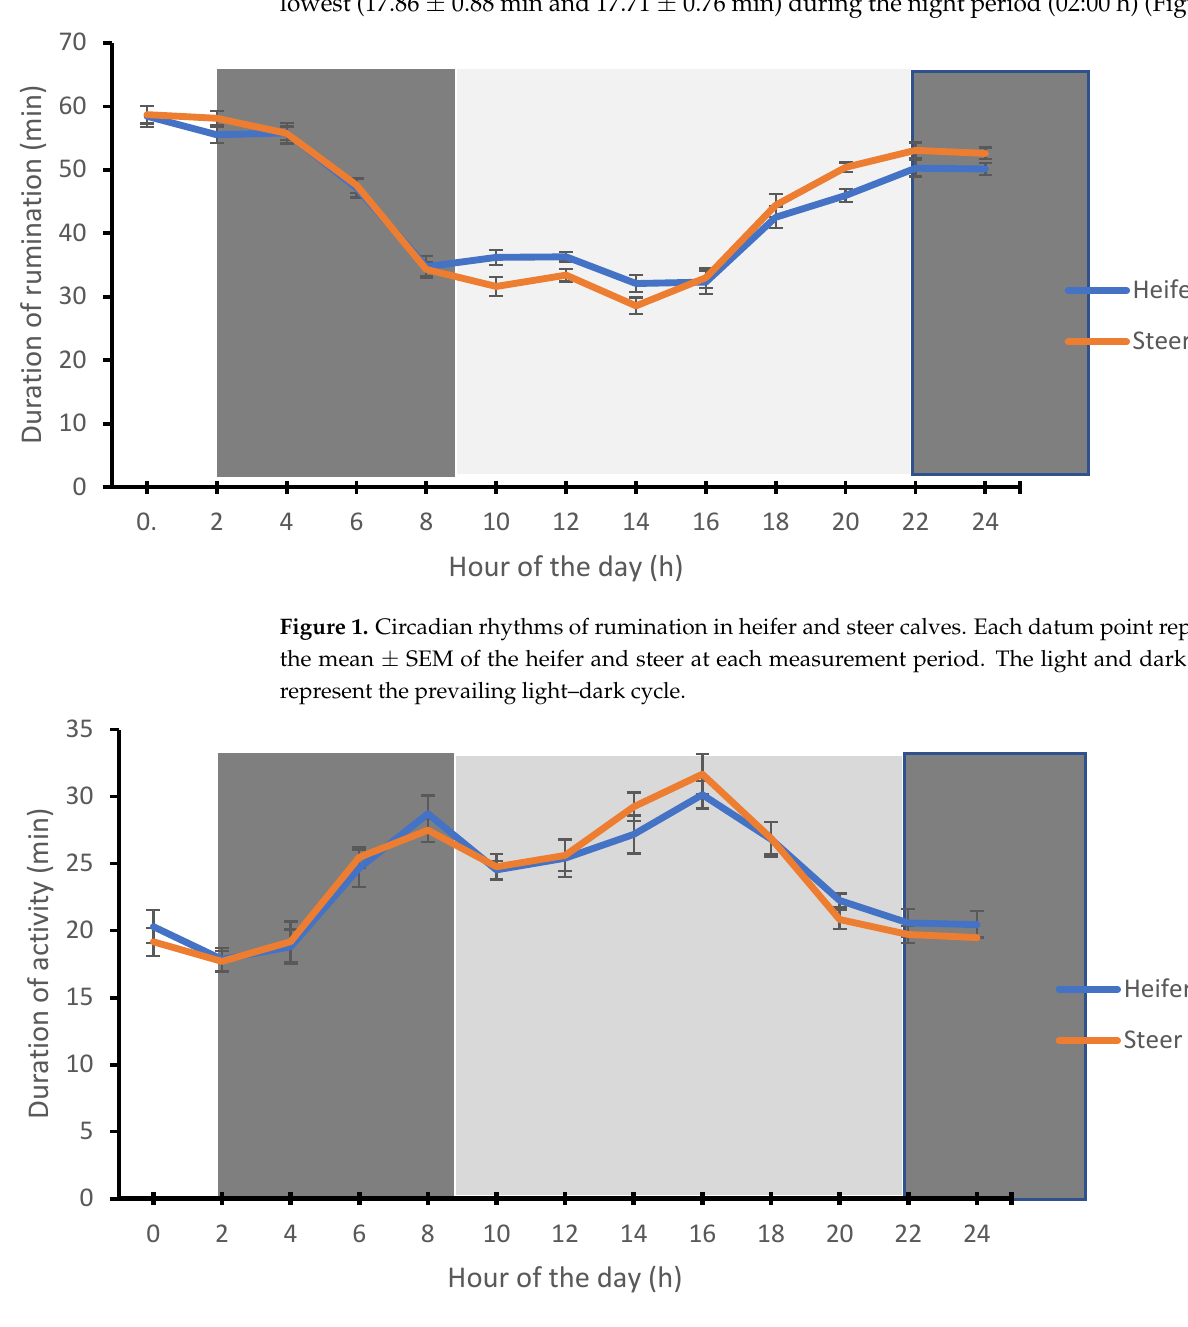
Figure 2. Circadian rhythms of activity behaviors in heifer and steer calves. Each datum point represents the mean ± SEM of the heifers and steers at each measurement period. The light and dark shades represent the prevailing light–dark cycle. The rumination time was highest at midnight (0:00 h) for the Angus (59.31 ± 1.31 min) and Angus-cross (57.54 ± 1.28 min), respectively. In contrast, the lowest time spent